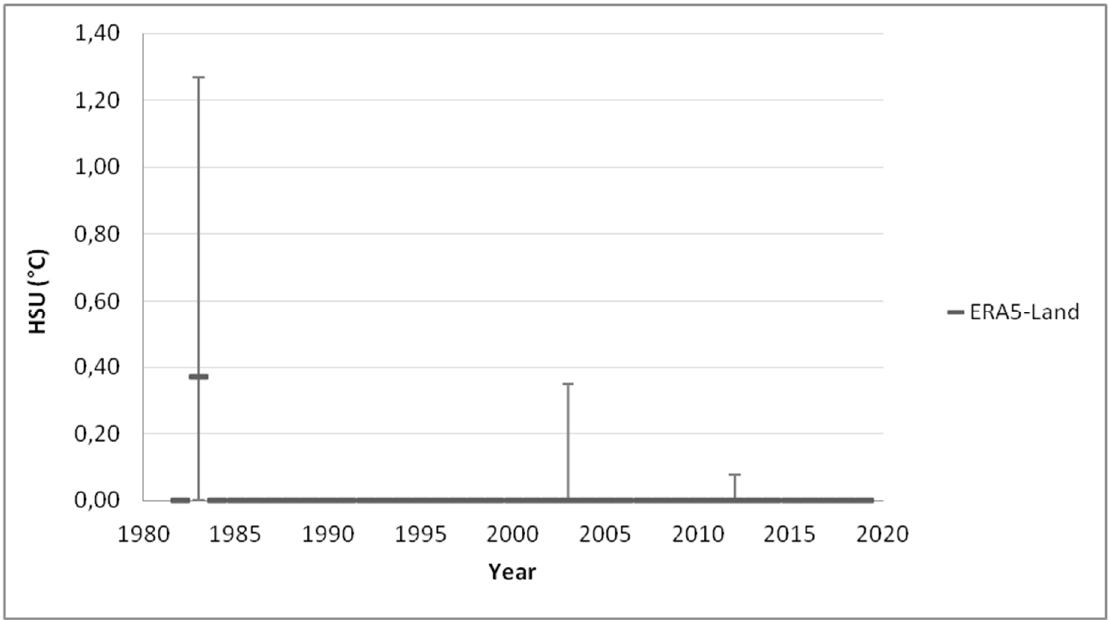
Figure 10. Graph of frost-free periods with uncertainties between the years 1982 and 2019.